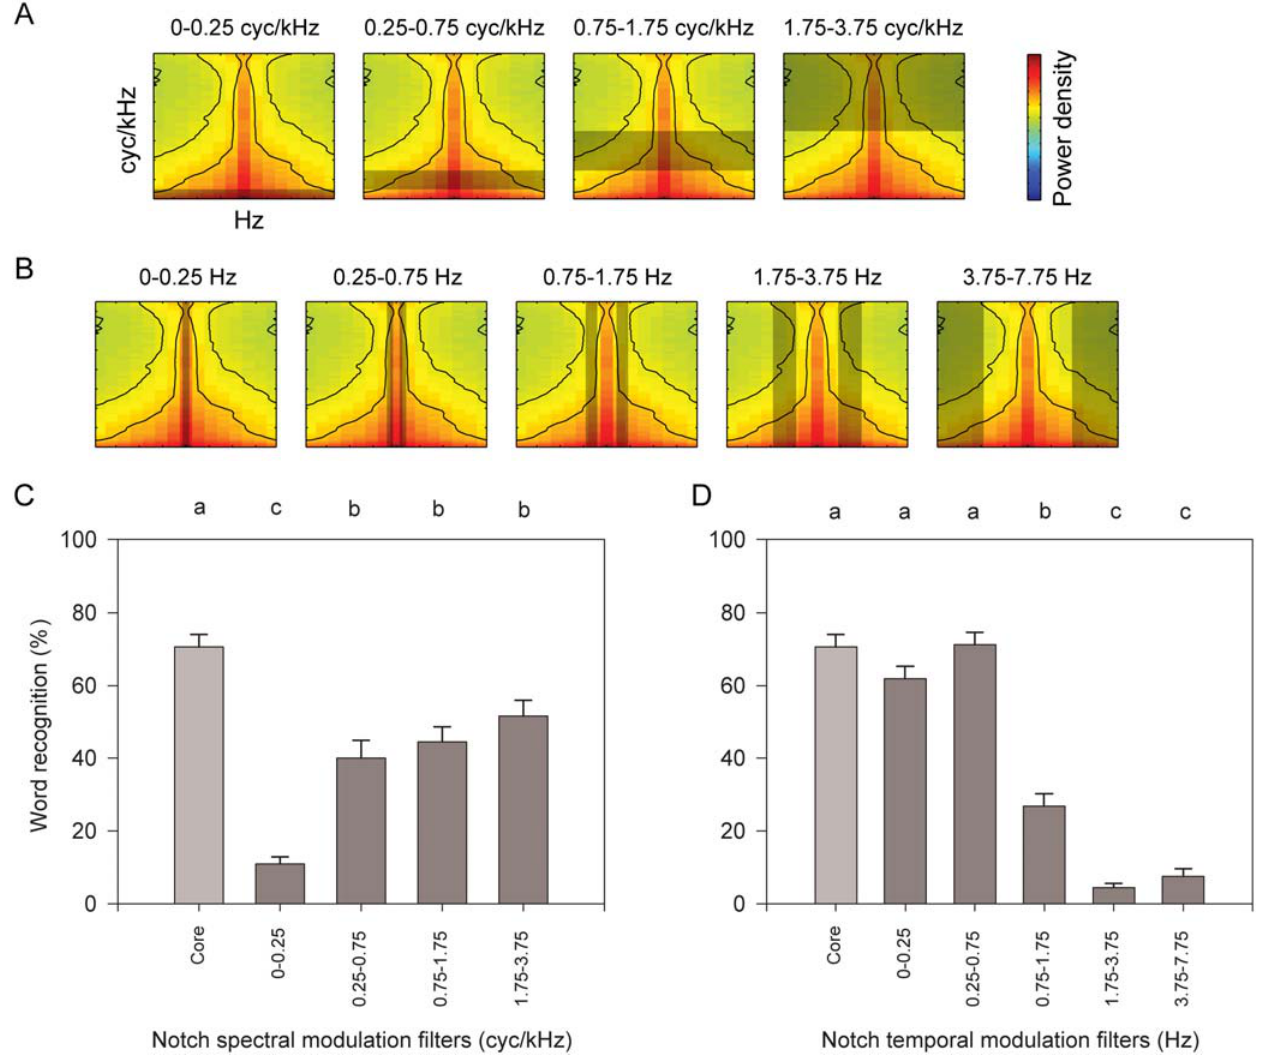
Figure 5. Comprehension of ‘‘core’’ modulations in speech with notch filtering. (A,B) Notch filters in the spectral (A) or temporal (B) modulation domain removed modulations from sentences that contained only core modulations after having been low-pass filtered in both domains. As depicted in Figure 4C, x- and y-axes are 0 to 6 7.75 Hz and 0 to 3.75 cycles/kHz, respectively. (C,D) Comprehension when spectral (C) or temporal (D) notch filters were applied to sentences containing only core modulations. See Figure 6C for a thumbnail of the core modulations. As in Figures 5 and 6, conditions which share no lower-case labels in common are significantly different (repeated measures ANOVA).